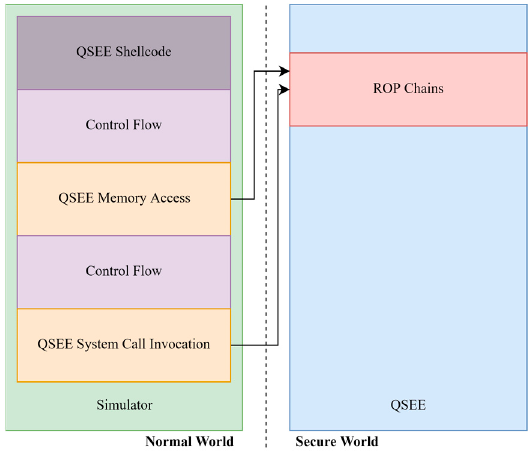
Figure 8. Emulating QSEE Code and Partially Offloading it to QSEE.